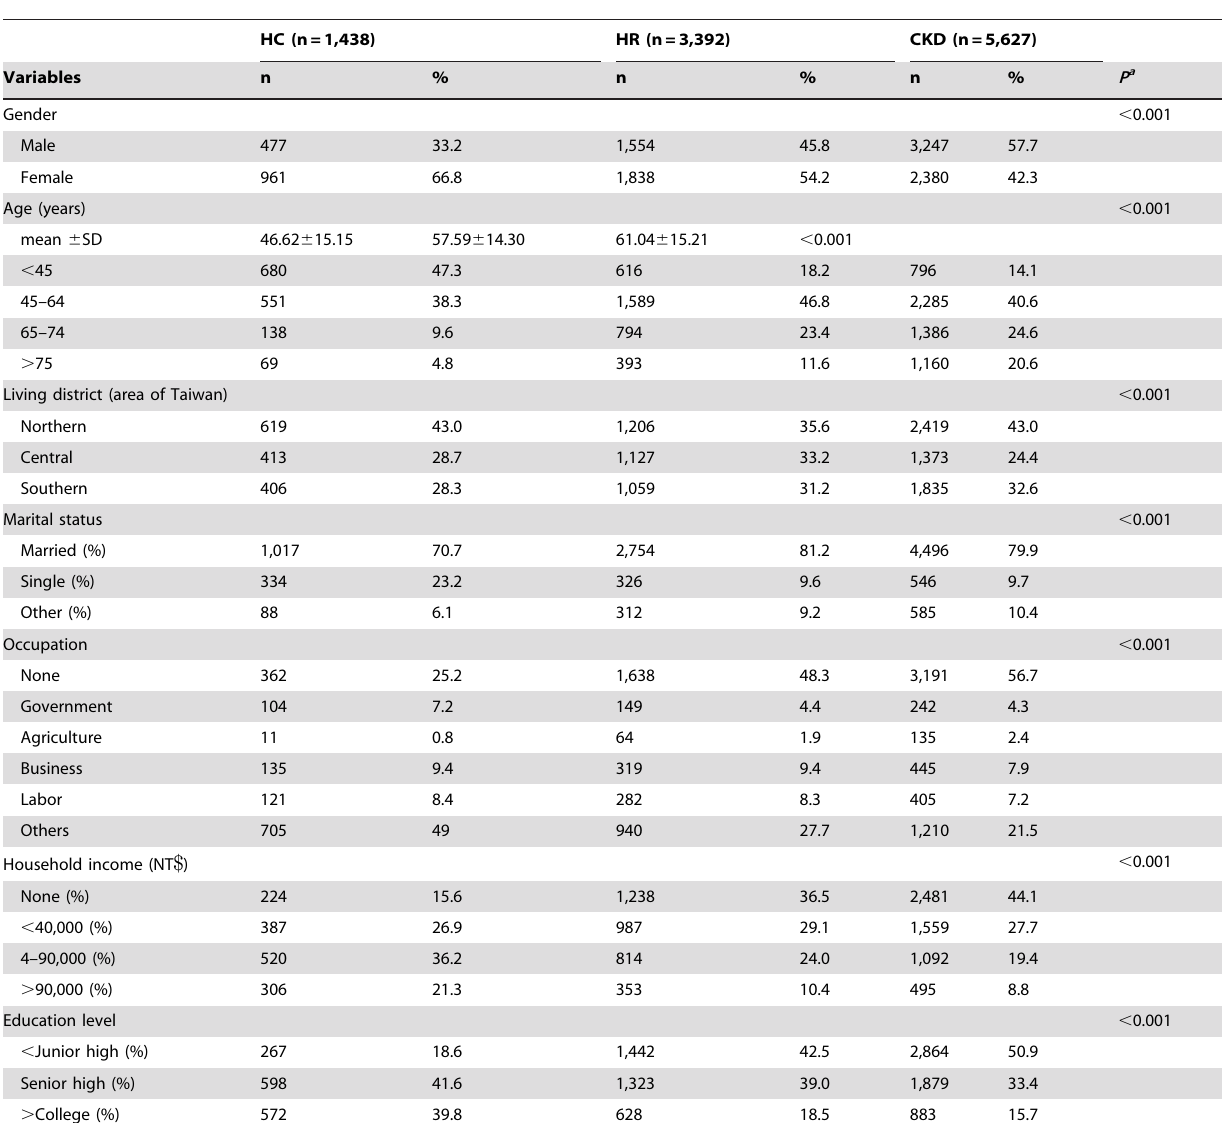
Table 1. Demographic characteristics and socioeconomic status of eligible